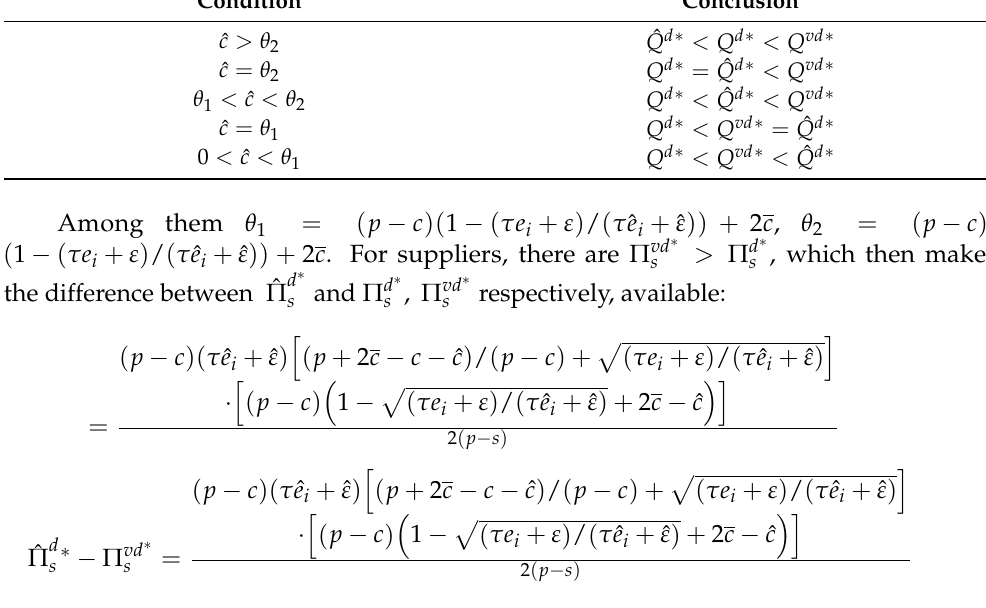
Table 2. Comparison of retailer order quantity under the Stackelberg game. Condition